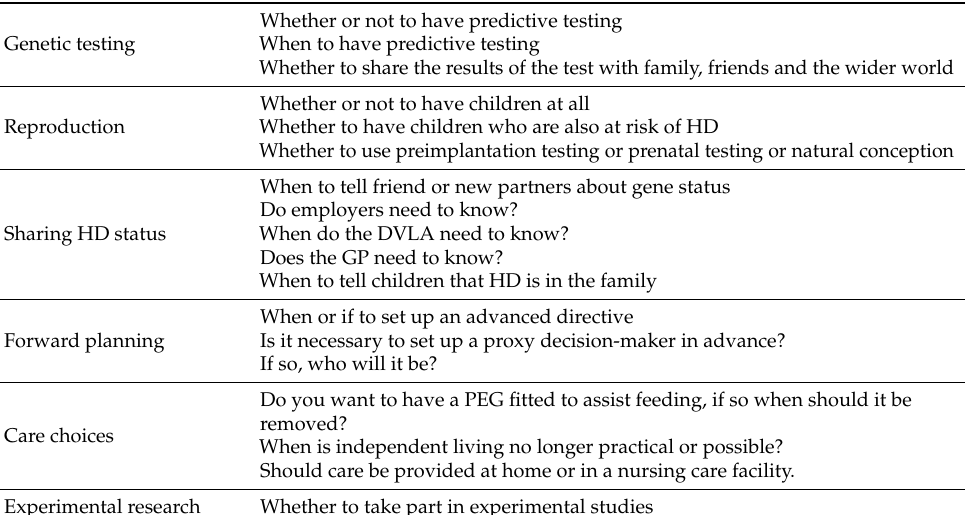
Table 2. Examples of decisions Huntington’s disease gene carriers